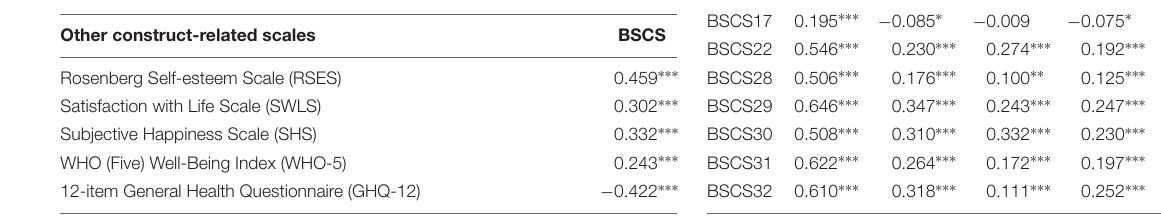
TABLE 2 | Correlation between 13-item BSCS scale in relation to other validation